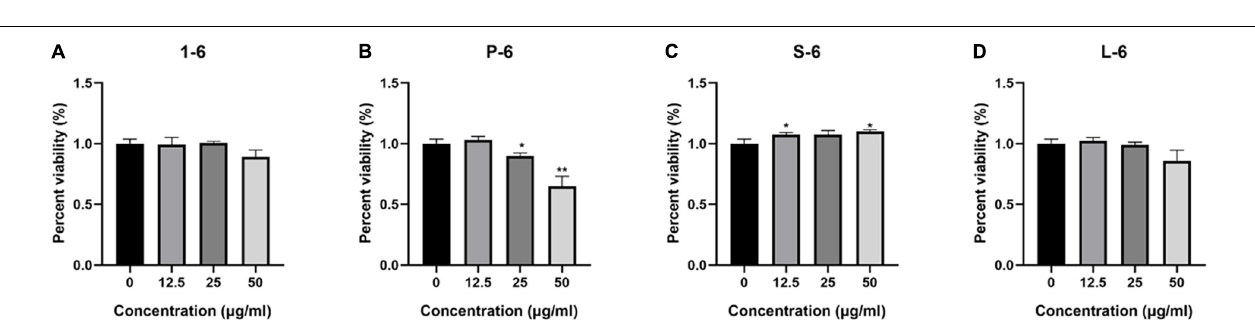
FIGURE 10 | The percent viability of RAW264.7 cells. The percent viability of RAW264.7 cells in the presence of 1–6 (A) , P-6 (B) , S-6 (C) , and L-6 (D) . The t -test was used to evaluate significant differences between controls and treatment groups. * p < 0.05, ** p < 0.01.